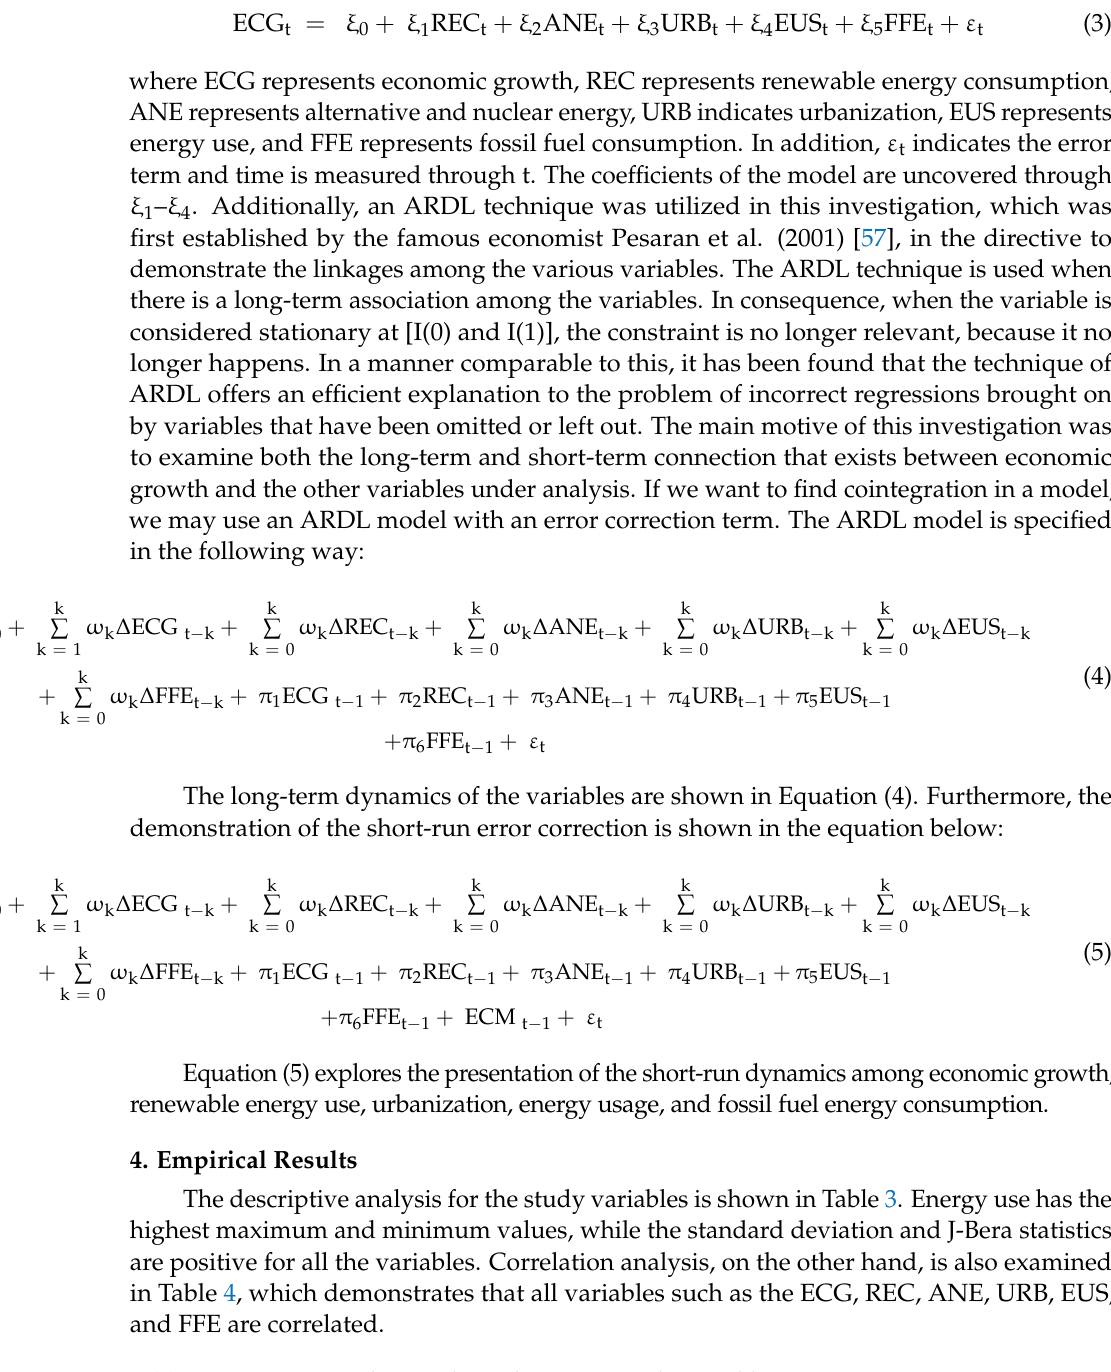
Table 4. Descriptive analysis and correlation among the